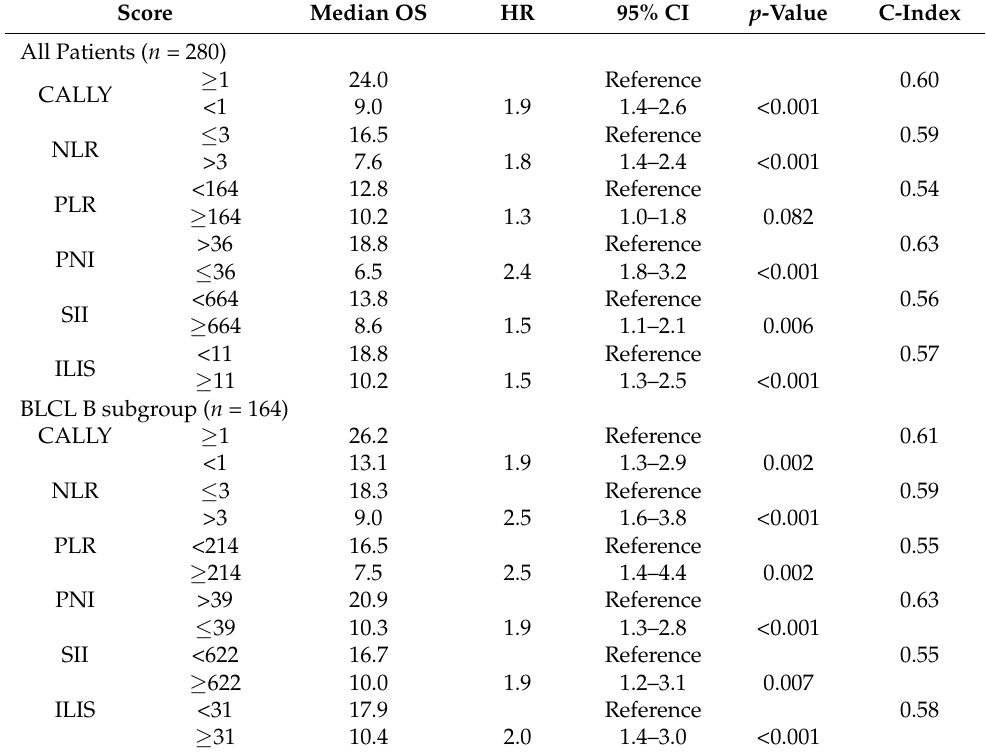
Table 5. Comparison of the CALLY index to existing immunonutritive and inflammation